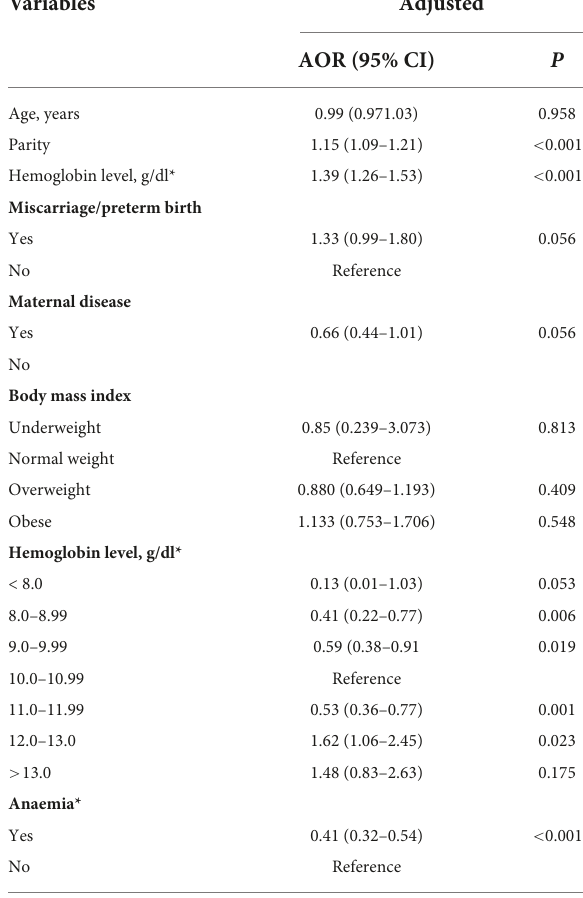
TABLE 3 Logistic regressions of sociodemographic and clinical variables associated with preterm birth in Khartoum, Sudan, 2020.